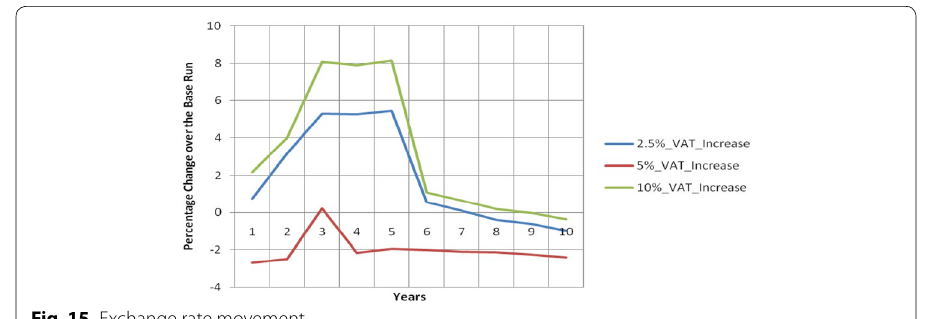
Fig. 15 Exchange rate movement